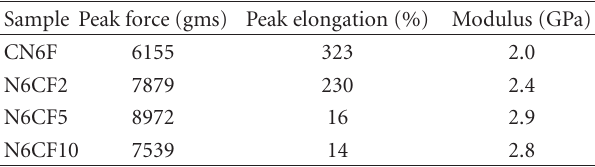
Table 4: Tensile strength results of nylon-6 nanocomposite films.